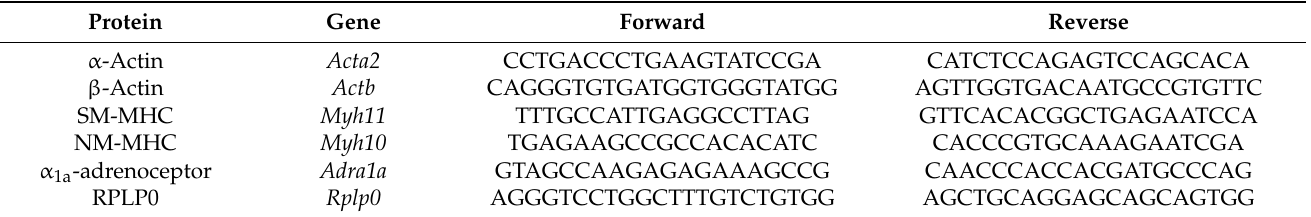
Table 4. Gene-specific primers used in